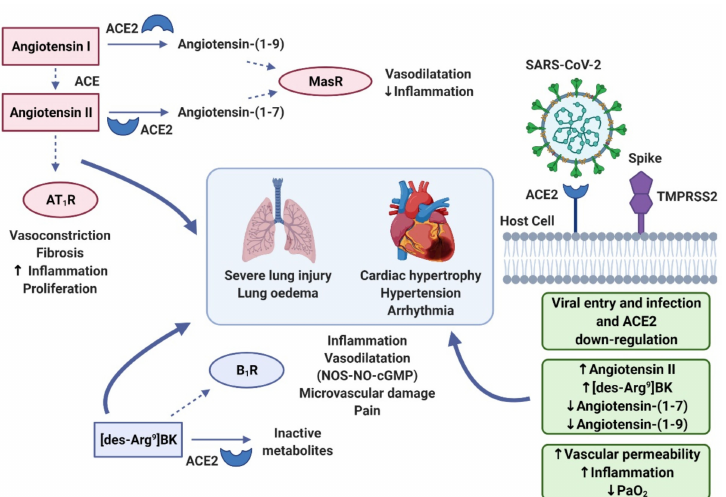
Figure 5. RAAS and Bradykinin Systems in SAR-CoV-2 infection. SARS-CoV-2 infection results in interaction with transmembrane protease, serine 2 (TMPRSS2) and ACE2, leading to subsequent down regulation of ACE2 [27]. This loss of ACE2 function leads to decreased metabolism of Ang II to Ang(1-7) and Ang(1-9). This leads to an increased activation of AT 1 R by Ang II and reduced activation of MasR. The resulting increased inflammation also leads to an increased expression of B 1 Rs. As a consequence, AT 1 R and B 1 receptor stimulation facilitates the pathophysiological responses associated with COVID-19, such as ARDS and CVCs (Figure adapted from [107]; created with